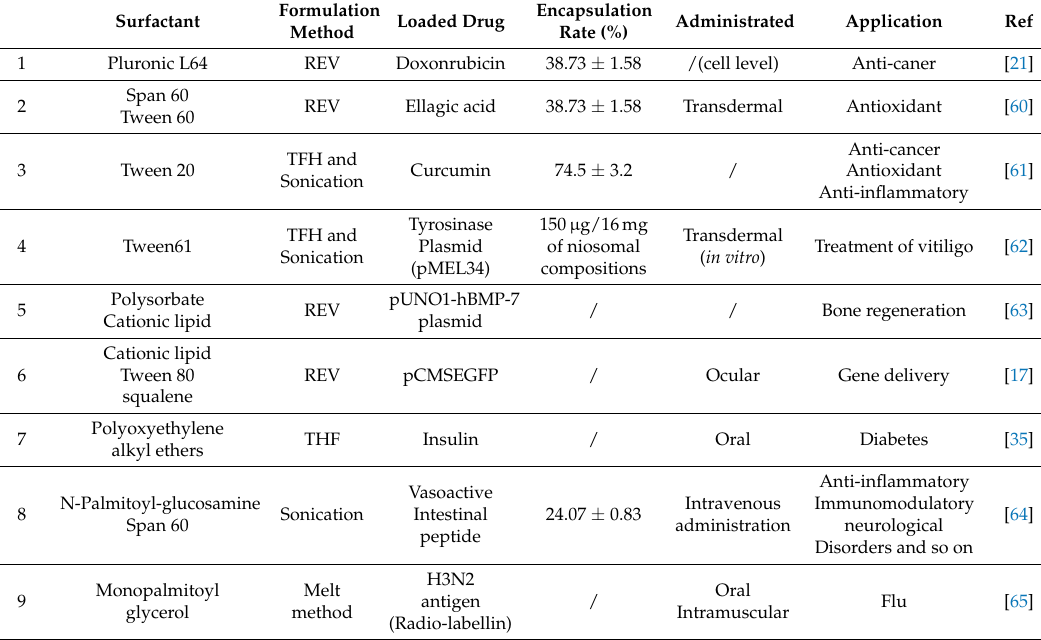
Table 3. The application of niosomes in delivering of